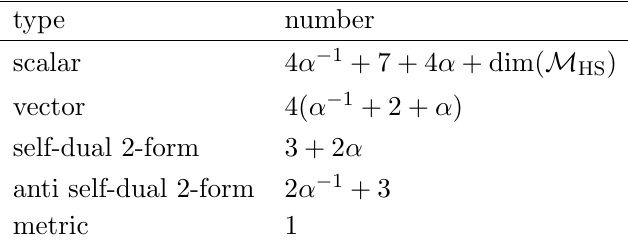
Table 3 . Six-dimensional (cid:12)elds after the compacti(cid:12)cation of type IIB supergravity on the hyper- elliptic